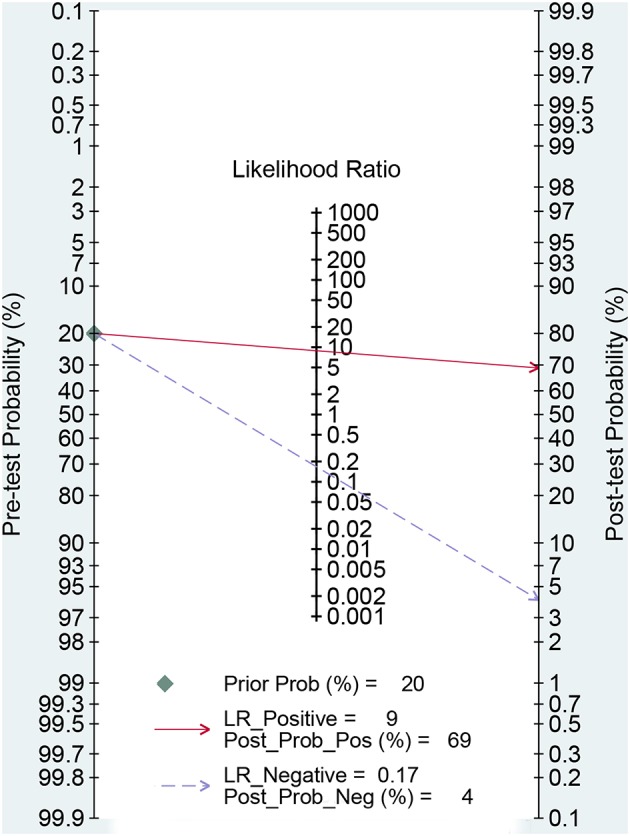
Fagan diagram assessing the overall diagnostic value of serum Zta antibody for NPC.